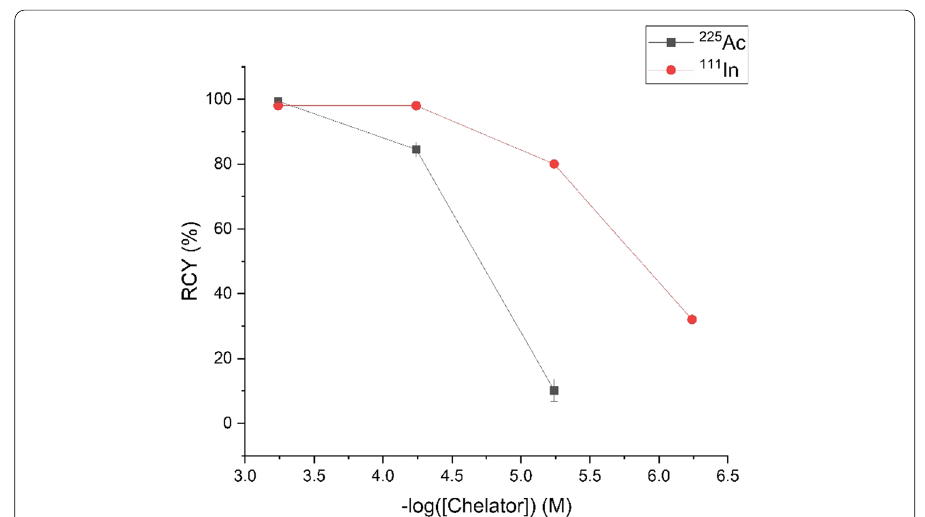
Fig. 2 Radiochemical yields (RCYs, %) for 225 Ac 3 + (80 °C, 60 min, 0.15 M ammonium acetate, pH 7) and 111 In 3